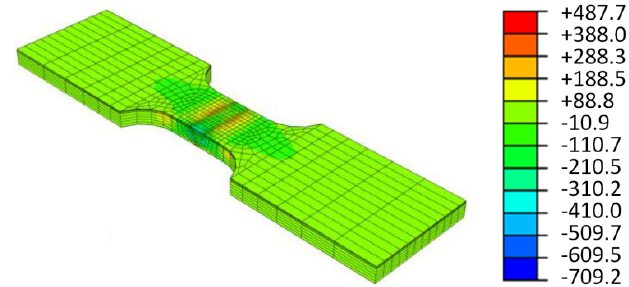
√ area > 1000 µ m [30]. Figure 3. Numerical model for structural weld simulation in case of test series √area > 1000 µm [30].